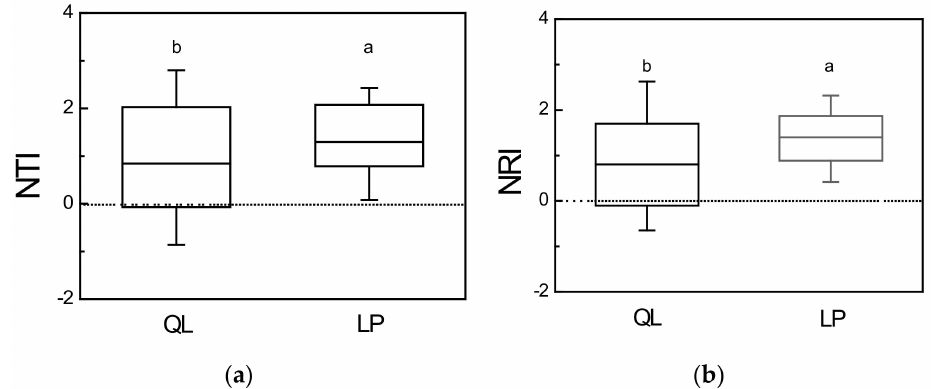
Figure 2. The nearest taxon index (NTI) and net relatedness index (NRI) of the Qinling Mountains (QL) and the Loess Plateau (LP). The boxes show the range of values of NTI ( a ) and NRI ( b ) in each region. The dotted lines at 0 level represent the null expectation of NTI or NRI. The letters “a” and “b” indicate significant di ff erences between boxes.